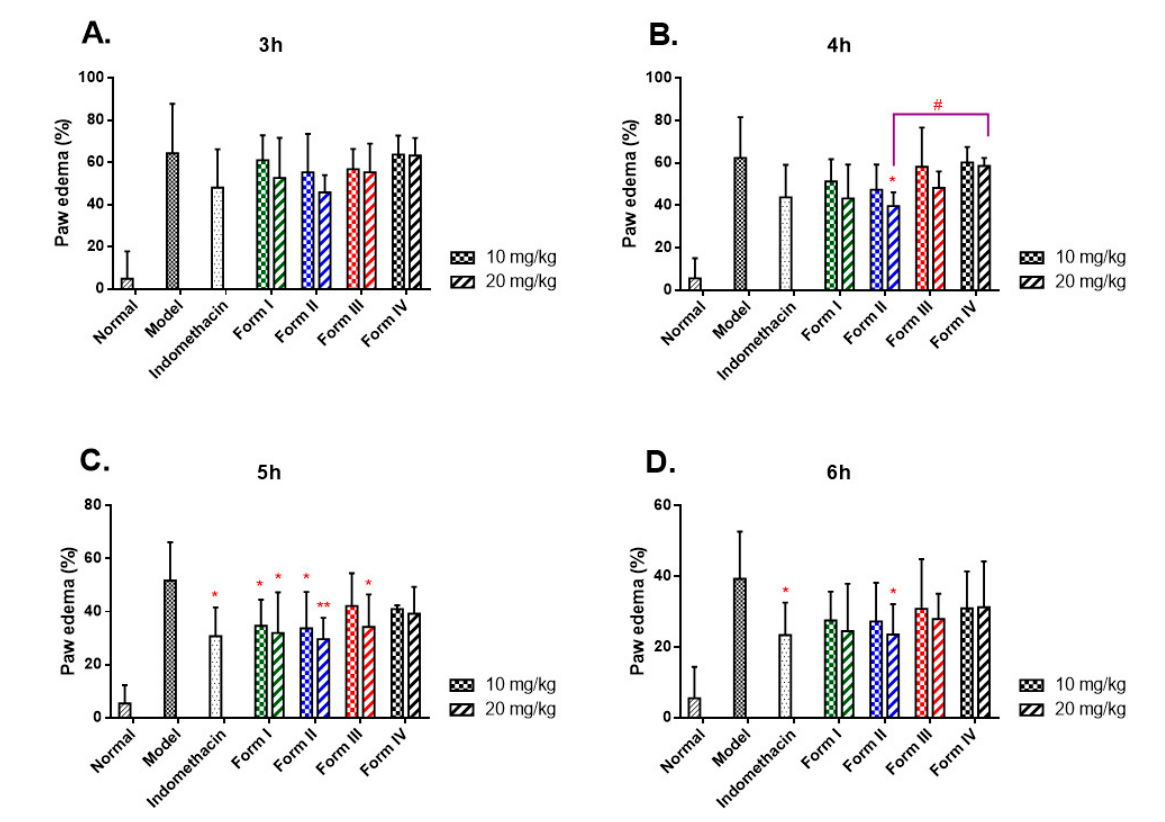
Figure 4. Results of paw swelling test induced by carrageenan of the four forms of CK at doses of 10 and 20 mg/kg in rats at different time intervals: ( A ) 3 h; ( B ) 4 h; ( C ) 5 h; and ( D ) 6 h. Values are expressed as mean ± SD of 6 rats in a group. *: p -value < 0.05, **: p -value < 0.01, versus the model group; #: p -value < 0.05, form II versus form IV (4 h, 20 mg/kg).